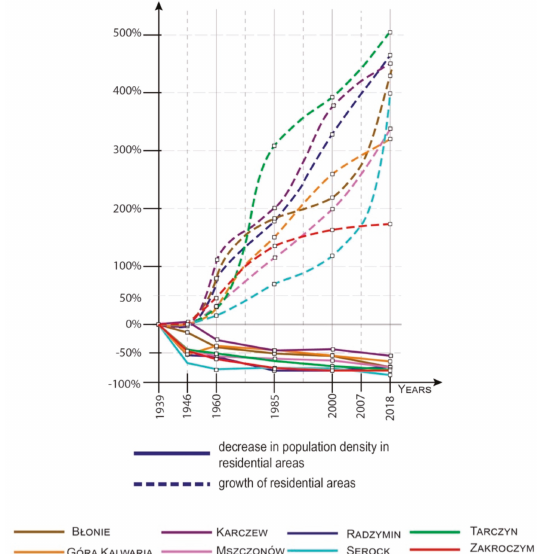
Figure 6. Changes in population density in the studied cities in the years 1939–2018 (for Tarczyn, the analysis concerned the period 2002–2018). Source: own study based on numerical data for specific time periods according to Table